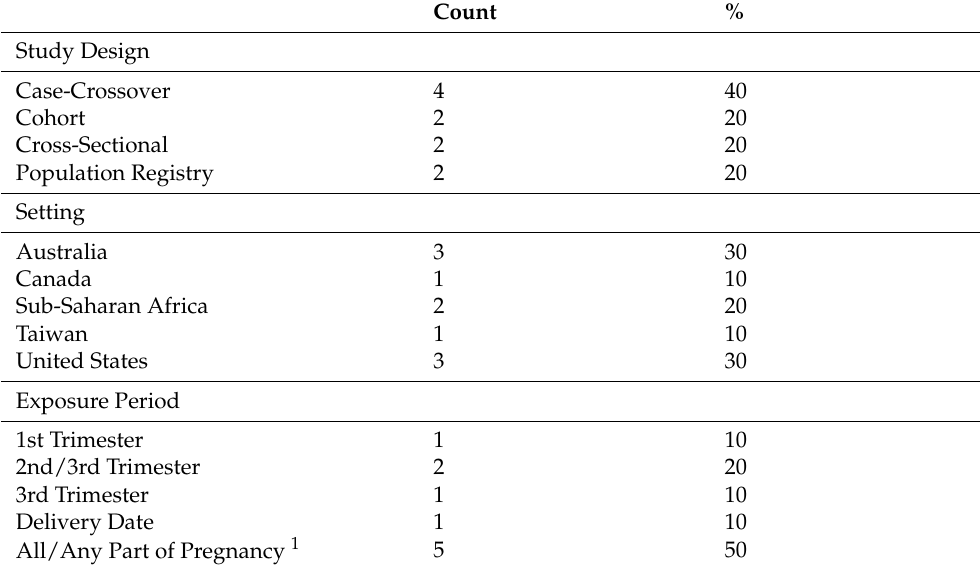
Table 6. Stillbirth Study Characteristics n =